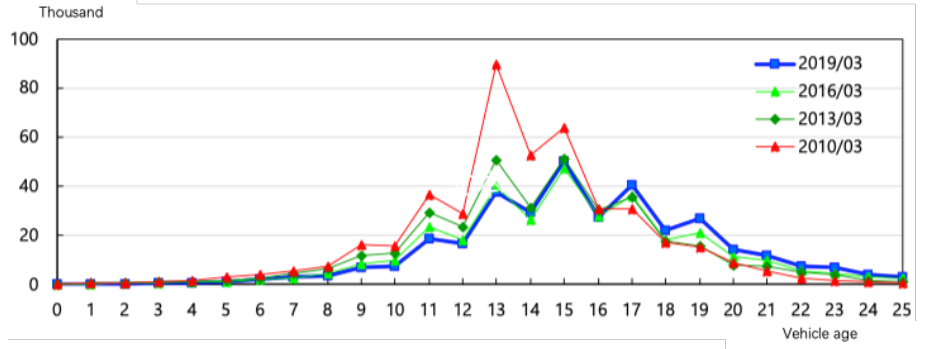
Figure 1. Age of recycled End-of-Life vehicle in Japan. Source: Japan Automobile Recycling Promotion Center (JARC) [19]. Note: Figure 1 is made by Japan Automobile Recycling Promotion Center originally.